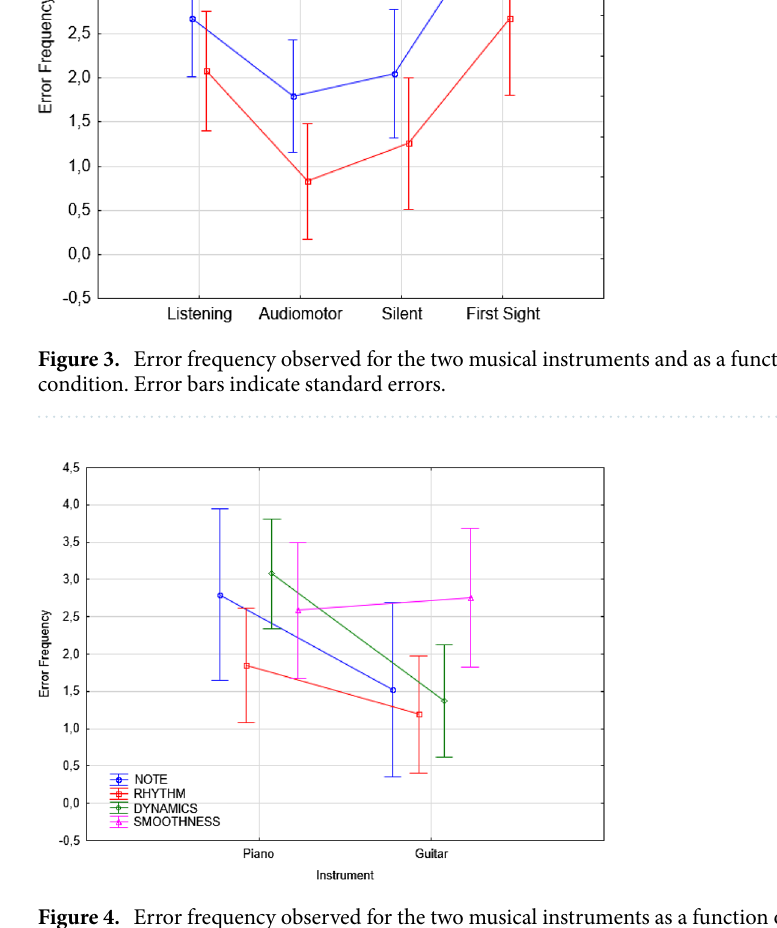
Figure 4. Error frequency observed for the two musical instruments as a function of error type (regardless of the students’ level and learning condition). Error bars indicate standard